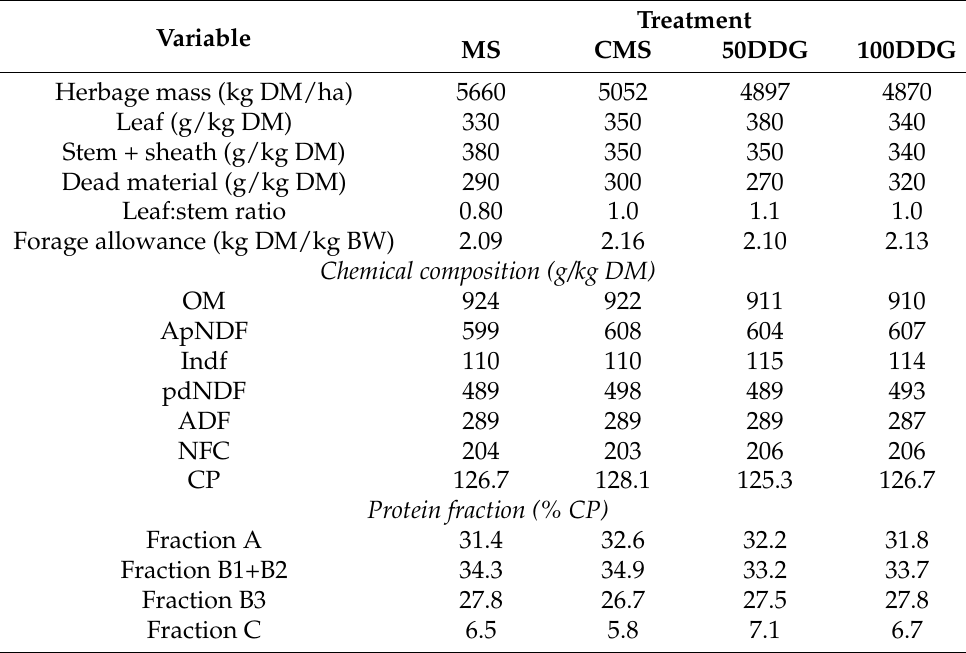
Table 3. Herbage mass (HM), morphological composition, herbage allowance (HA), and chemical composition of Urochloa brizantha cv Marandu pastures, during the wet